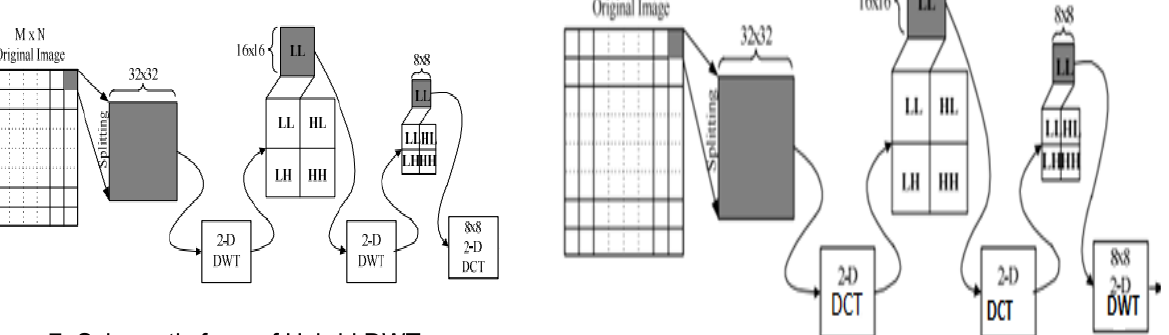
Figure 7. Schematic form of Hybrid DWT- DCTAlgorithm